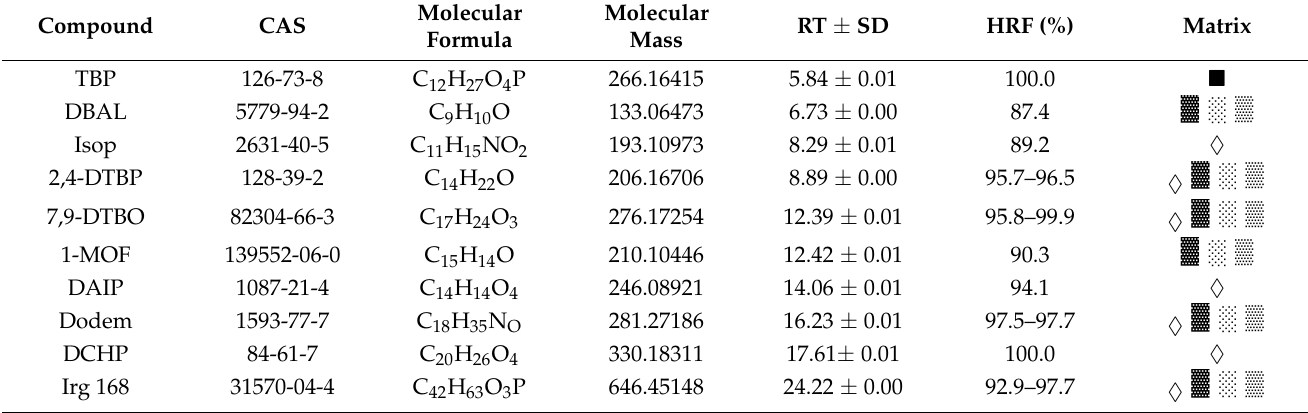
Table 3. Compounds tentatively identified by unknown analysis in leaves of P. oceanica ( ♦ ), rhizomes ( (cid:4) ) and marine sediments such as V-sed